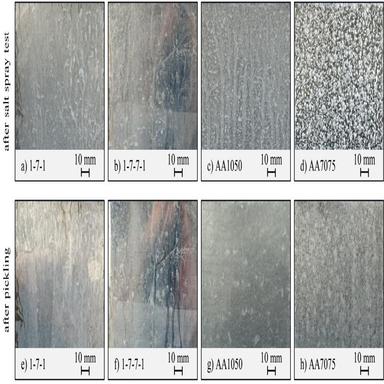
Sheets of multilayered materials 1-7-1 and 1-7-7-1 as well as base materials AA1050 and AA7075 a)-d) after the salt spray test and e)-h) after pickling.